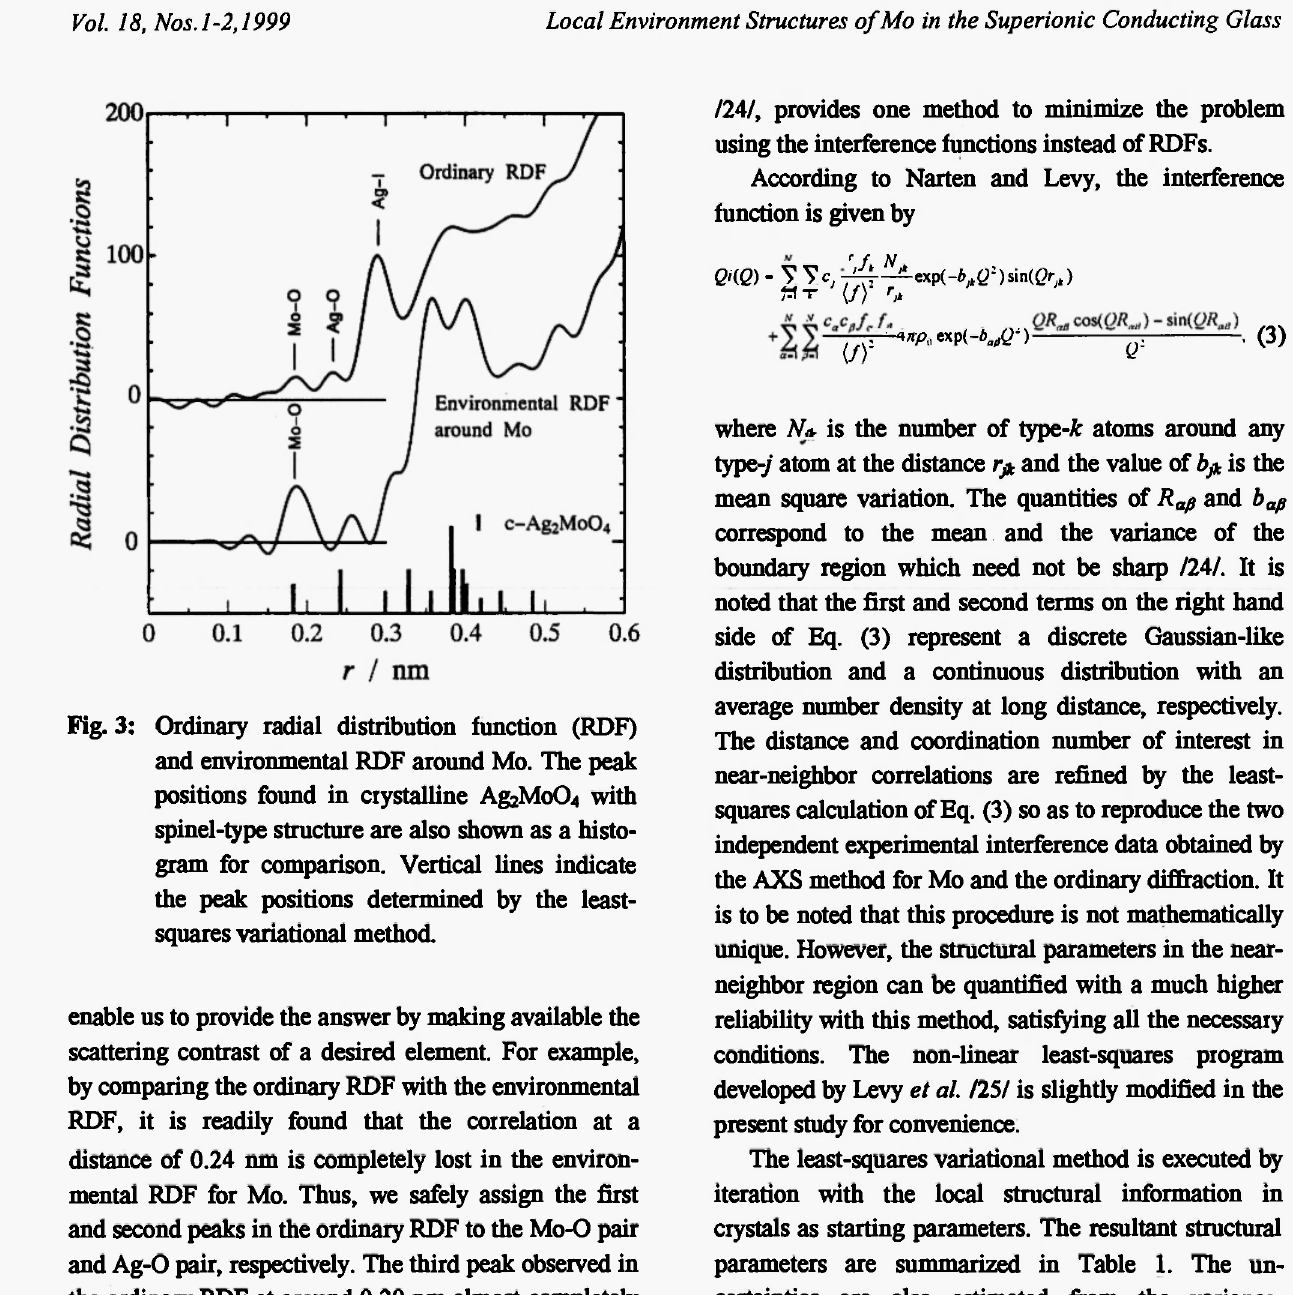
Fig. 3: Ordinary radial distribution function (RDF) and environmental RDF around Mo. The peak positions found in crystalline Ag 2 Mo0 4 with spinel-type structure are also shown as a histo- gram for comparison. Vertical lines indicate the peak positions determined by the least- squares variational